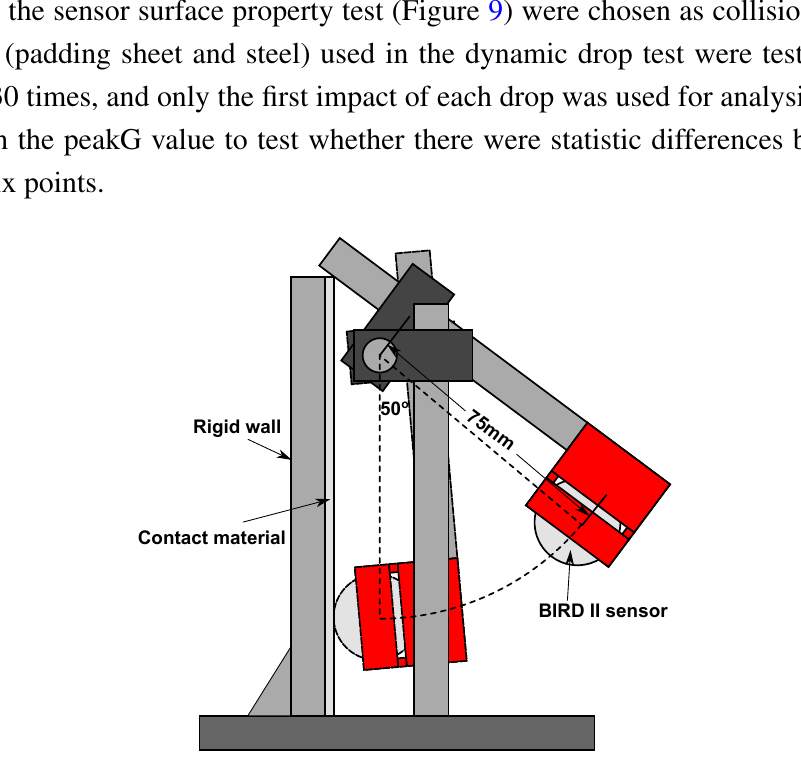
Figure 10. Schematic of the pendulum test (side